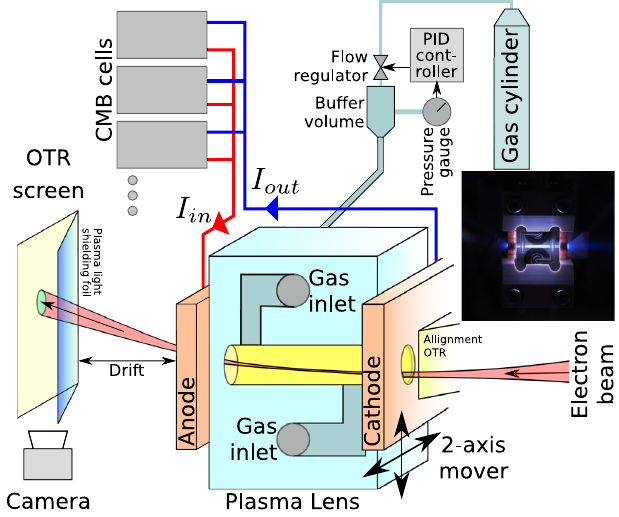
FIG. 1. Overview of the most relevant components of the CLEAR Plasma Lens Experiment and the path of the beam. Insert: Plasma lens capillary during a